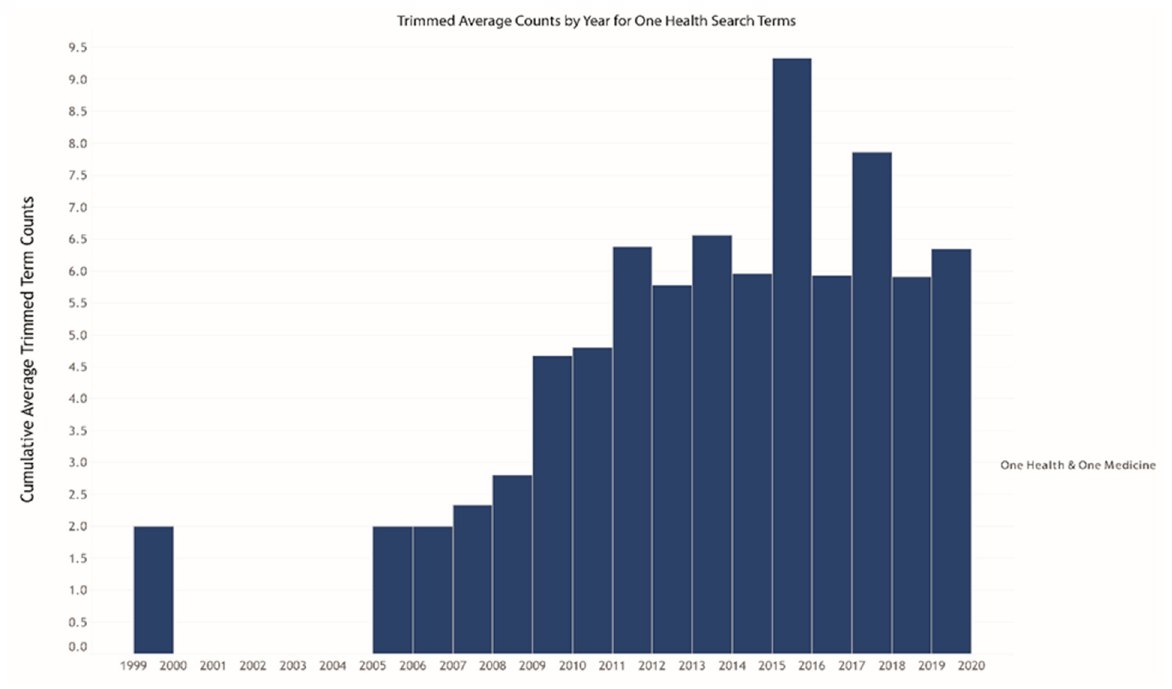
Figure 3. The cumulative average trimmed (top and bottom 10 percentile omitted) term ounts from 1990 to 2019, binned by the One Health domains. Returned articles that contained search terms related to antimicrobial resistance in title and/or abstract are shown based on bins: ( A ) Human-associated, ( B ) Environmental-associated, ( C ) Animal-associated, and ( D ) One Health associated.